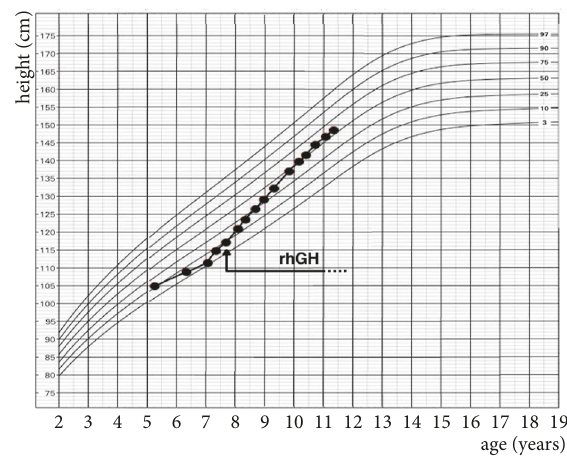
Figure 1: Height growth chart of patient. Recombinant human growth hormone (rhGH) therapy start indicated.